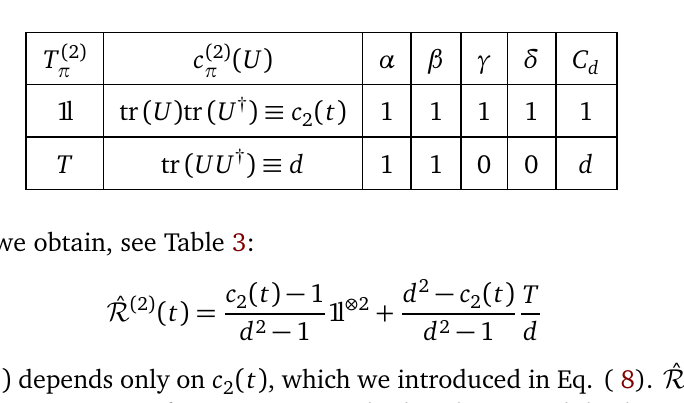
( U ) = C ( tr U α ) γ ( tr U † β ) δ , the cor- π d . See Eq. (8) for the short notation d